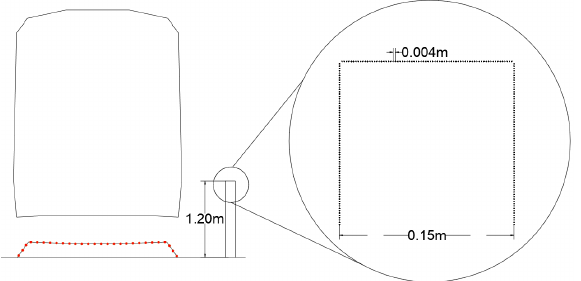
Figure 11. Boundaries to be described and the respective mesh of boundary